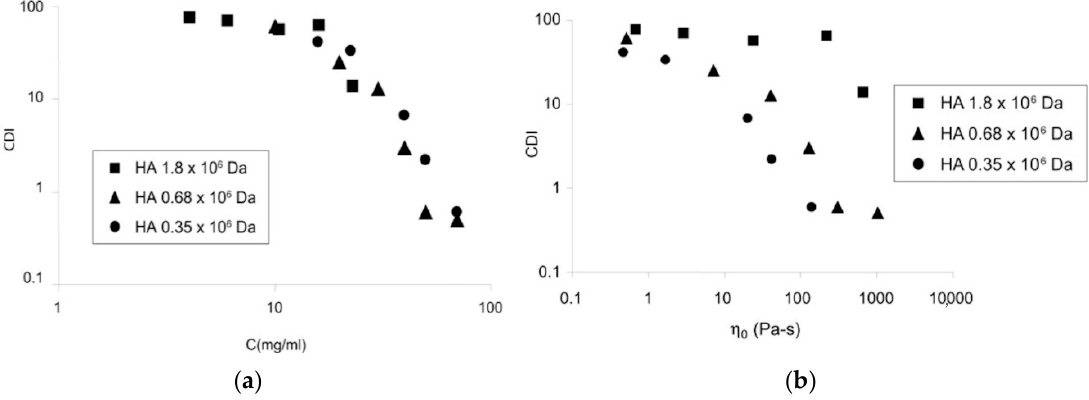
Figure 11. The CDI versus ( a ) the hyaluronic acid concentration and ( b ) zero shear viscosity. Reproduced from [49], with permission from John Wiley and Sons, 2020.